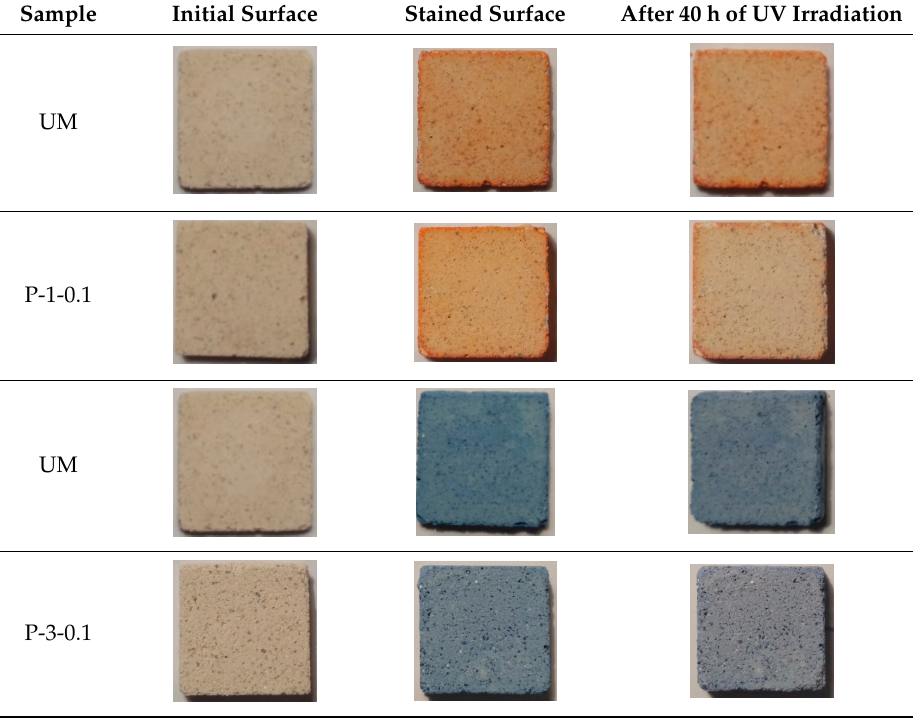
Table 3. Images of exemplary gypsum plates during the photocatalytic experiments.